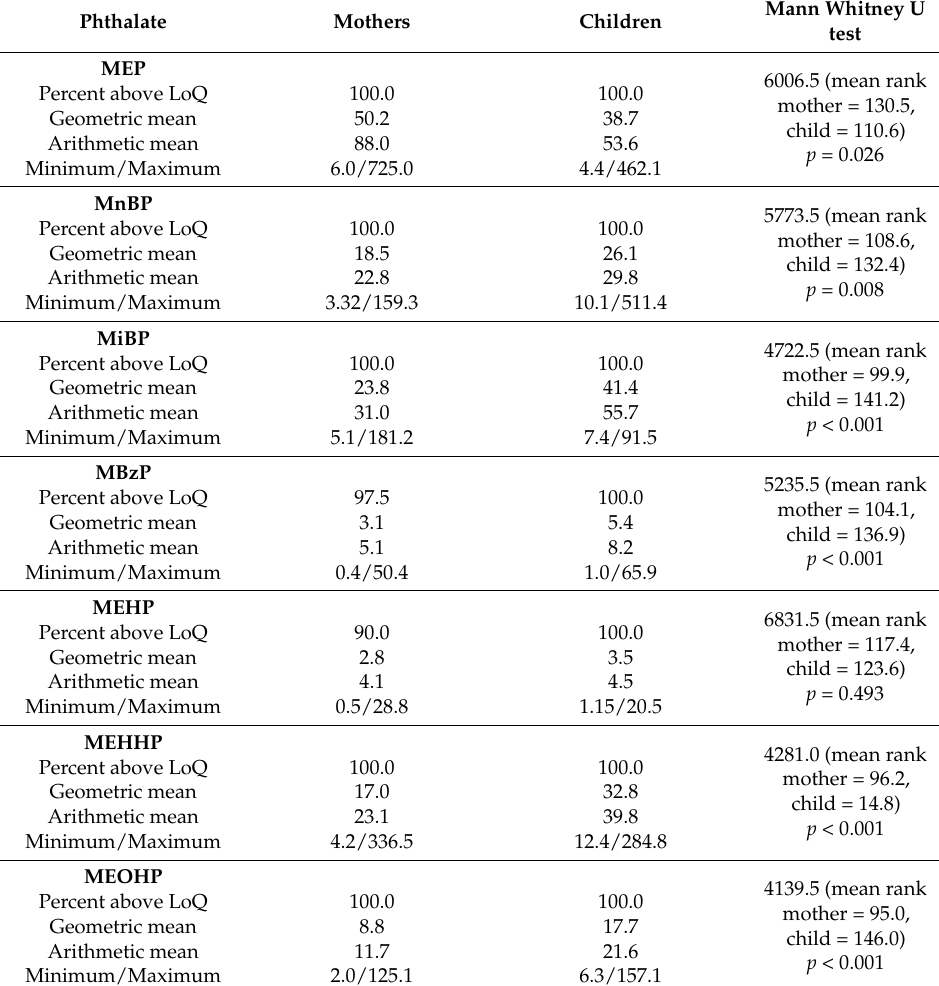
Table 3. Exposure of mothers and children to phthalates µ g/g (creatinine adjusted). Phthalate Mothers Children